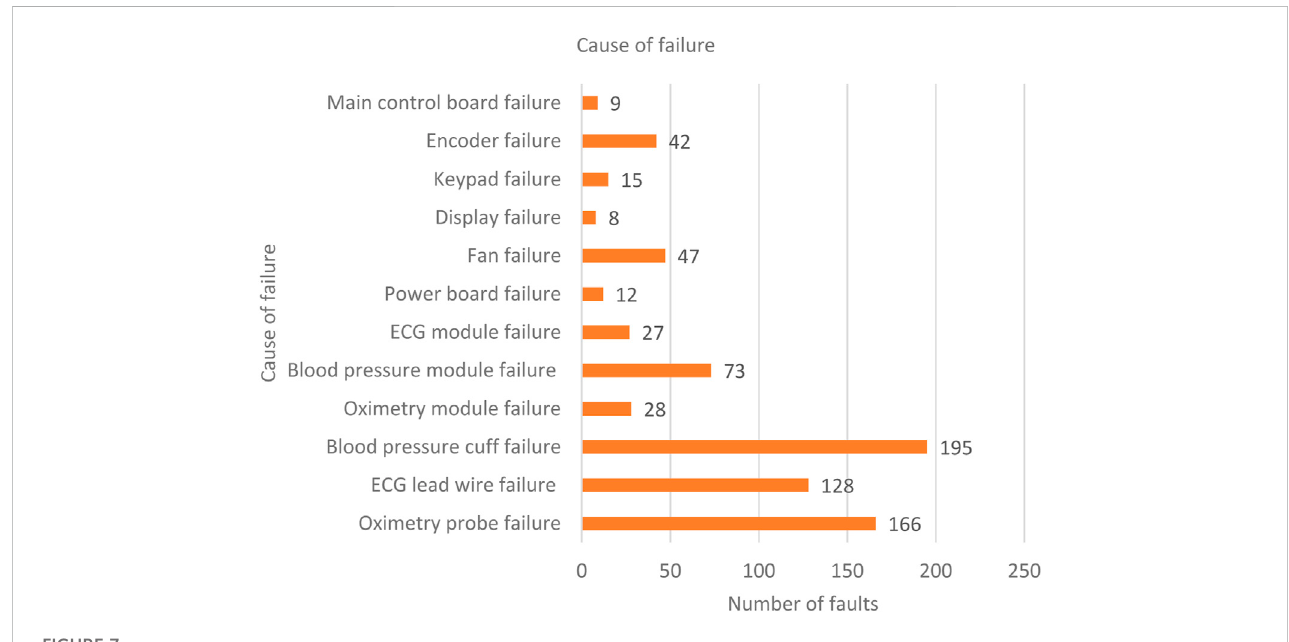
FIGURE 7 Statistics of failure cause.